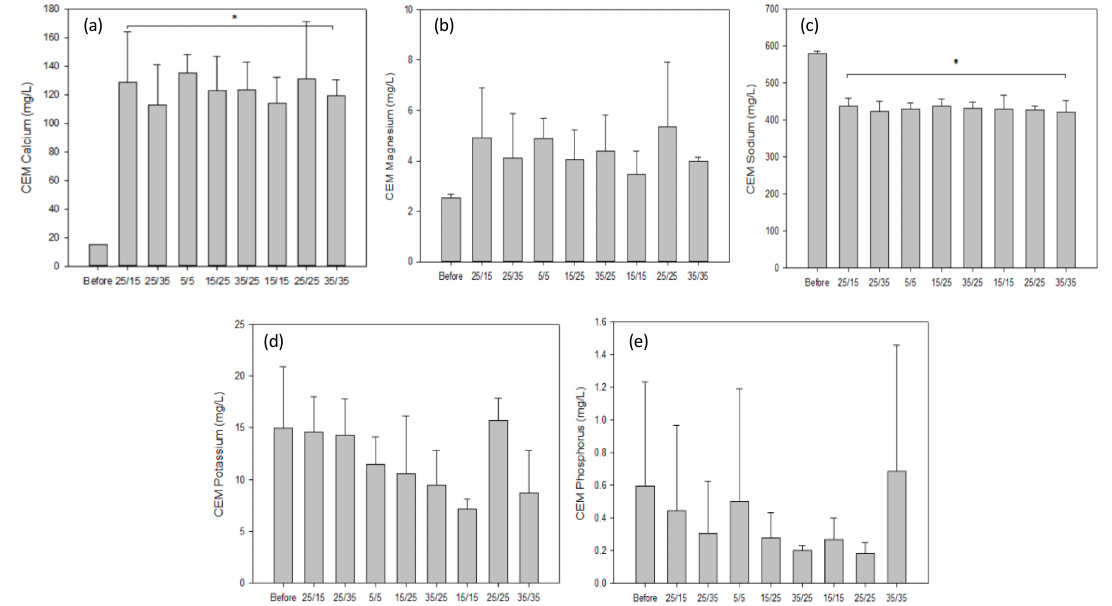
Figure 10. CEM mineral content for all PEF conditions tested. ICP-OES measurement was conducted after each ED run for ( a ) calcium, ( b ) magnesium, ( c ) sodium, ( d ) potassium, and ( e ) phosphorus and compared to the content of the pristine membrane. * there is a statistical difference between these values and that of the pristine membrane (P < 0.05) .